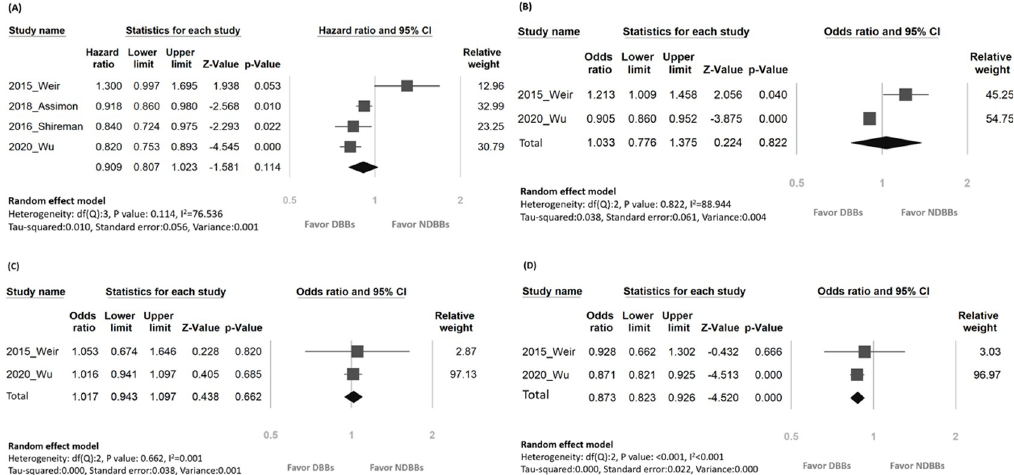
Fig 2. Forest plots comparing the risks of (A) all-cause mortality (aHR), (B) overall major adverse cardiac events (MACE), (C) acute myocardial infarction (AMI), (D) Heart failure (HF) between patients receiving dialyzable beta-blockers and those with non-dialyzable beta-blockers. aHR, adjusted hazard ratio; DBBs, dialyzable beta-blockers; NDBBs, non-dialyzable beta- blockers; CI, confidence